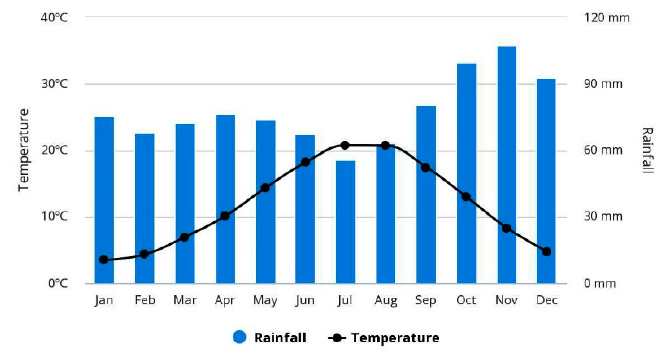
Figure 2. Average monthly temperature and precipitation in Italy from 1901-2016 [57].